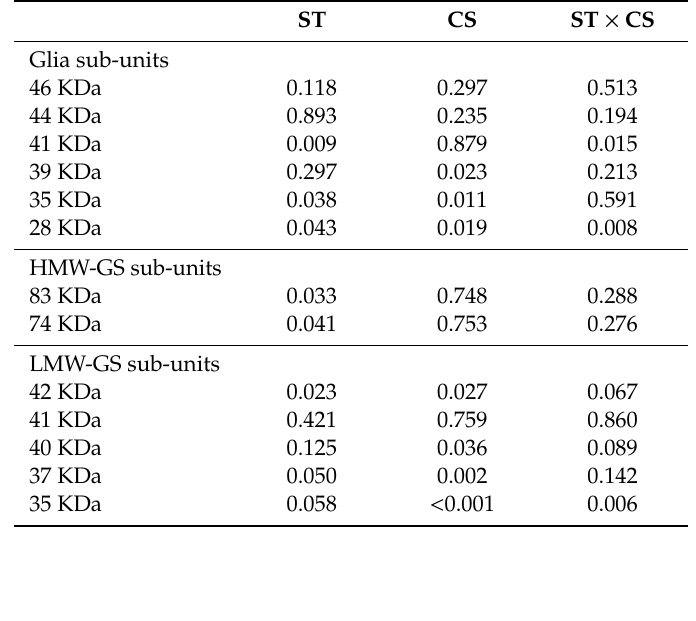
Figure 5. Grain protein content (GPC, %) as recorded for durum wheat at harvest in the 2016 ( A ) and 2017 ( B ) cropping seasons. Treatments: CT, conventional tillage; ZT, zero tillage; WW, durum wheat monocropping; WF, durum wheat-faba bean rotation. Data are averages ± standard errors of n = 3 Table 6. Summary of p -values from two-way analysis of variance (ANOVA) on the relative abundances independent replicates. (%) of Glia, HMW-GS, and LMW-GS detected sub-units in 2017. E ff ects: ST, soil tillage; CS, crop